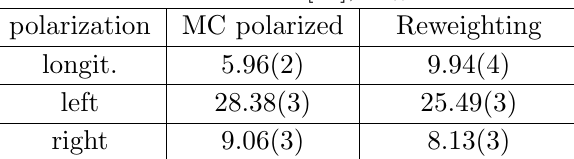
Table 15 . Polarized total cross sections ( ab ) for W + Z scattering in the region M WZ > 500 GeV: results of the reweighting procedure compared with results of the MC calculation with polarized amplitudes. The full set of cuts and neutrino reconstruction are understood.